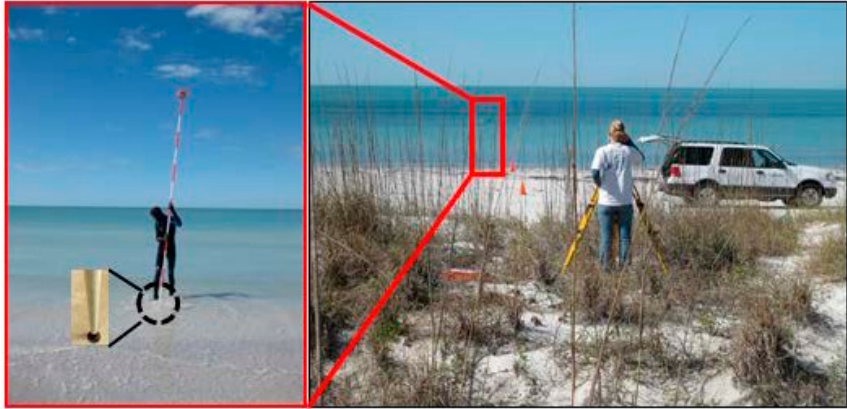
Figure 3. Survey procedures include the use of an electronic level-and-transit total station and a 4 m survey rod survey